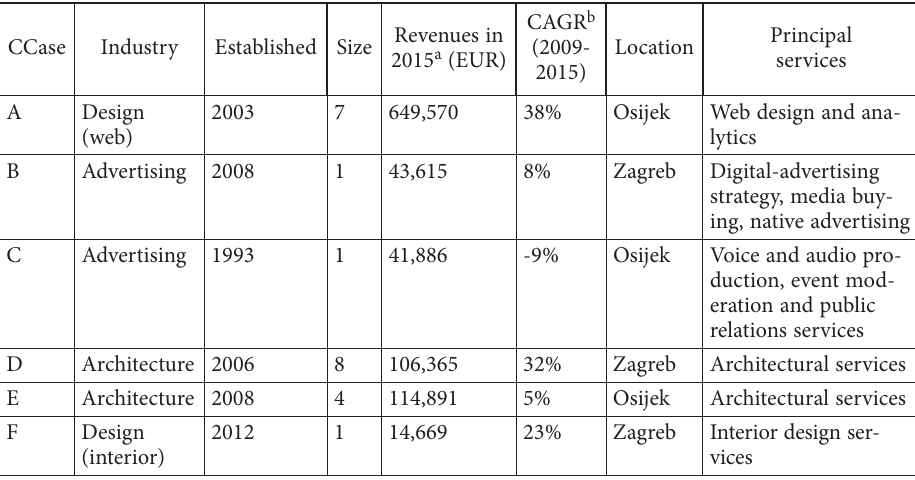
Table 1. Selected cases of microenterprises from creative professional services (CPSs) (source: Poslovna Hrvatska 2017 and transcripts of